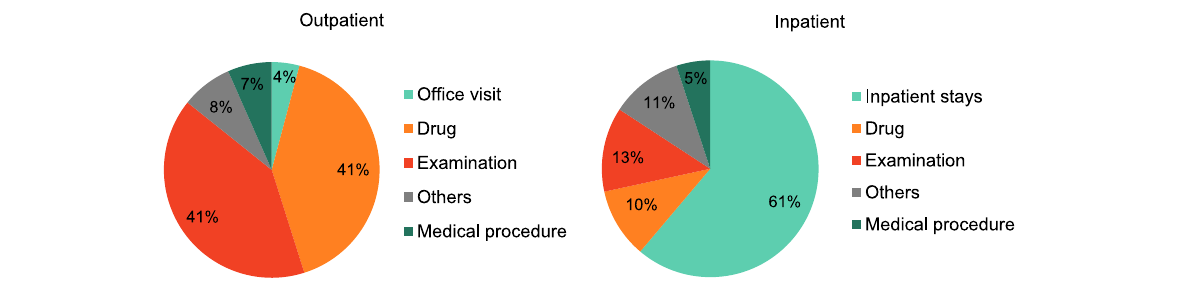
Fig. 2 The specific treatment costs as percentages of the total treatment